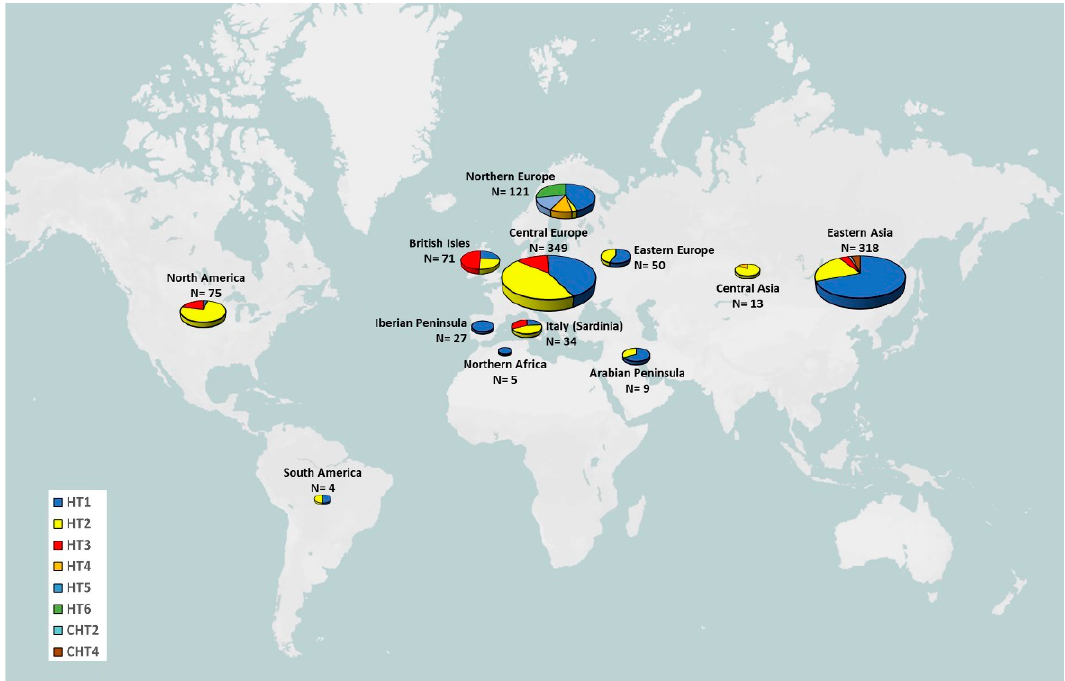
Figure 2. Geographic distribution of Y-chromosome haplotypes (classification as in [92,138]) among 76 modern horse breeds from different geographic areas. Further details are reported in Table S3.